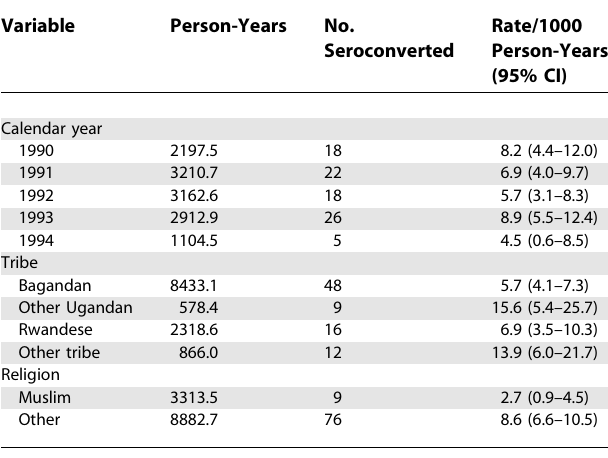
Table. Rates of HIV-1 Seroconversion by Selected